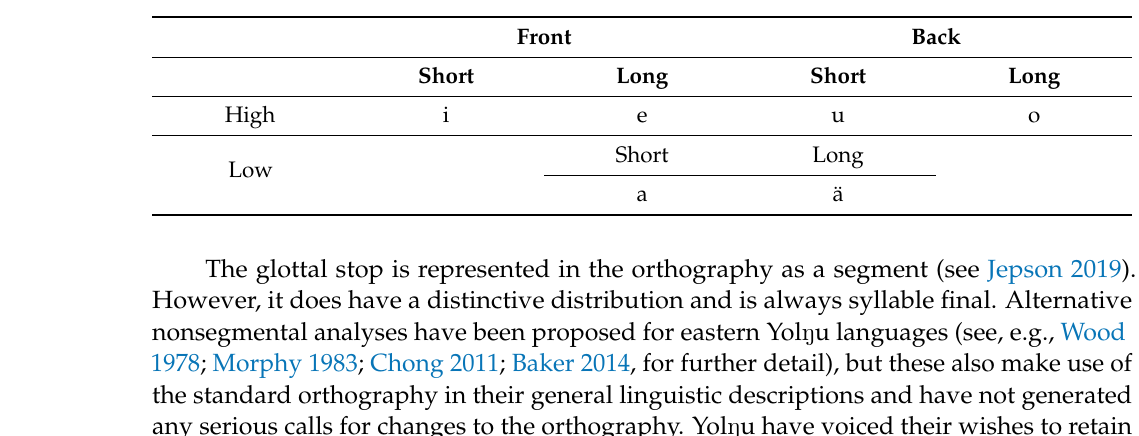
Table 2. Orthographic vowel